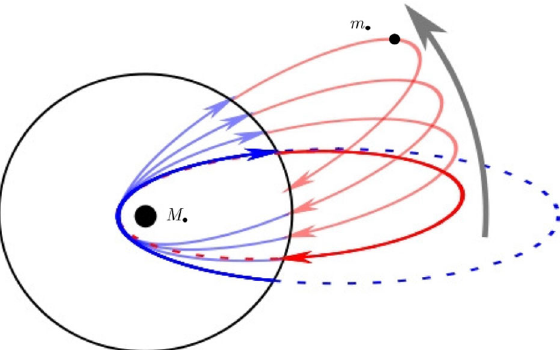
Fig. 11 In the Newtonian case we have an extended mass distribution, so that the star feels more mass far away than closer to the centre. When the star traverses the “sphere”, the trajectory abruptly changes and becomes a smaller ellipse Thus, the object goes back to the centre faster; the orbit precesses in the opposite direction to the orbital one In the relativistic case the kinetic energy of the star increases its gravitational mass when it’s close to the centre: The effective attraction is more efficient and the trajectory is more curved towards the centre